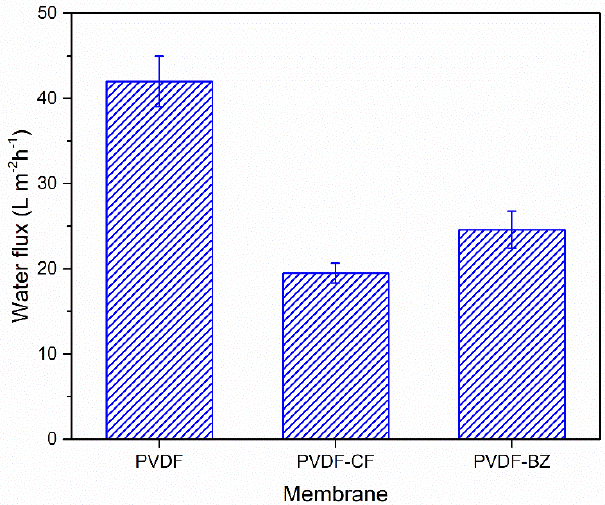
Figure 7. Permeate flux for PVDF, PVDF-CF, and PVDF-BZ membranes challenged with a feed stream consisting of a 3.5 wt% NaCl solution. The temperature of the feed and permeate streams was 60 °C and 20 °C, respectively. The error bars represent the range of triplicate results.